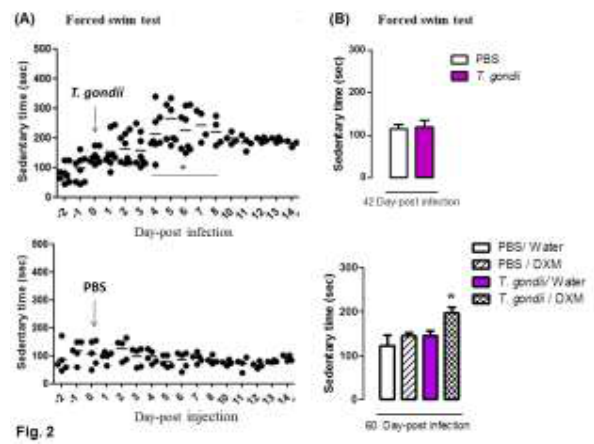
Fig. 2: Examination of sedentary time in the forced swim test (FST). (A) In T. gondii- infected or PBS-injected mice, sedentary time (immobility) was examined for 14 dpi. ( n = 10). (B) Immobility in FST was also examined before DXM treatment in T. gondii- infected and PBS-injected groups at 42 dpi ( n = 24, left) and after DXM treatment in 4 groups at 60 dpi ( n = 12, right). Data represent mean ± SD.